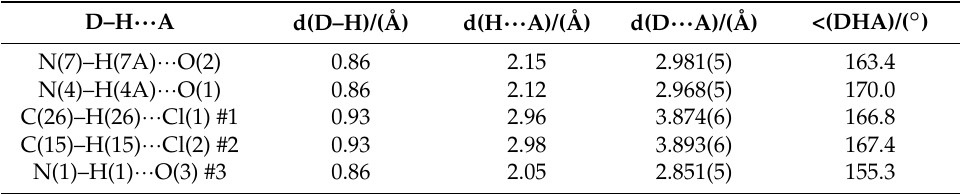
Figure 3. Structure of hydrogen bond trimer. Table 3. Hydrogen bonding interactions in Compound 1 .